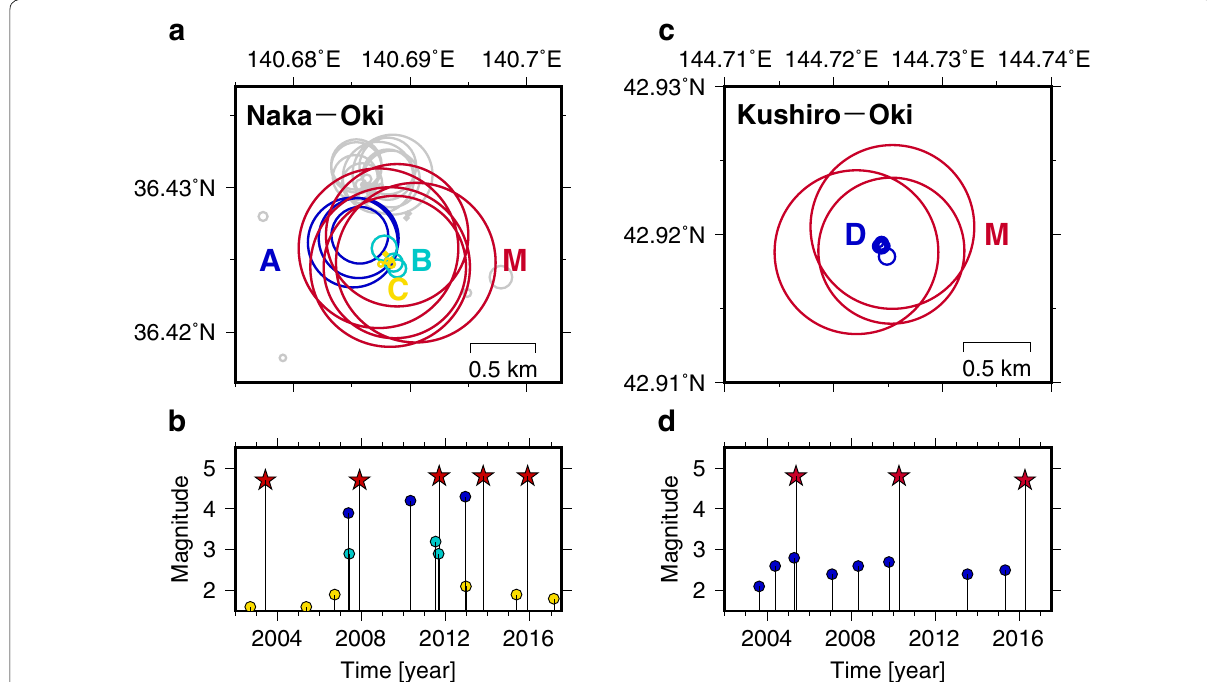
Fig. 2 Moderate-size repeating earthquakes in the Kushiro-Oki and Naka-Oki regions. a Earthquake distribution in the Naka-Oki region. The center and size of each circle represent the centroid location and estimated source size, respectively. The red, blue, cyan, and yellow circles indicate the group M, A, B, and C events, respectively. Gray circles show ungrouped events. b Magnitude–time diagram of the group M, A, B, and C events. c Earthquake distribution in the Kushiro-Oki region. The red and blue circles indicate group M and D events, respectively. d Magnitude–time diagram of the group M and D